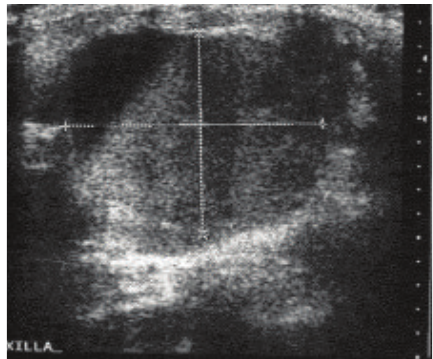
Figure 5: Ultrasound of the chest showing a heterogeneous solid cystic mass in the left